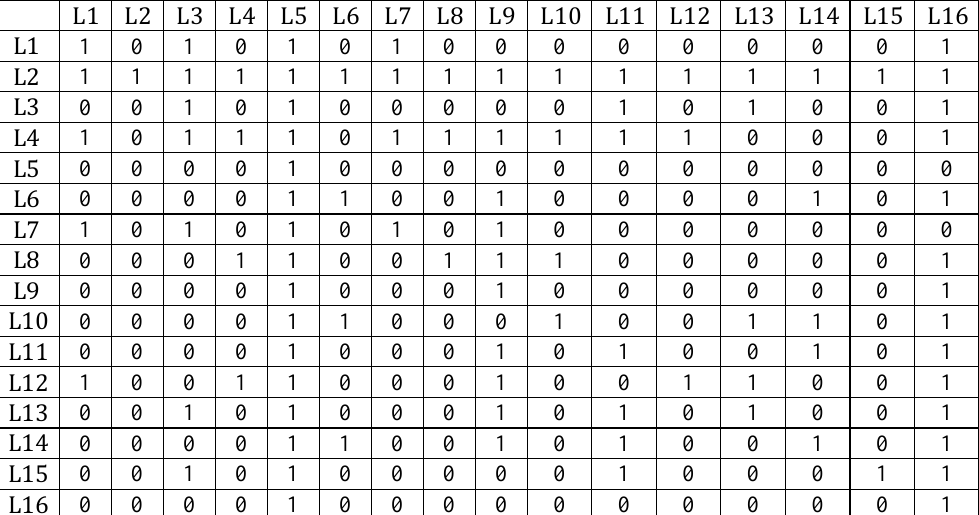
Table 9. Reachability Matrix (RM)